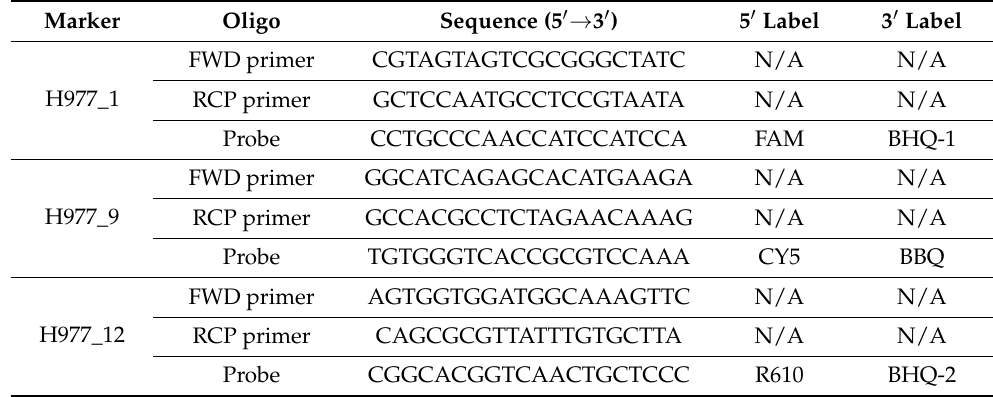
Table 3. Metarhizium brunneum EAMb 09/01-Su strain-specific markers, including primers and probes.